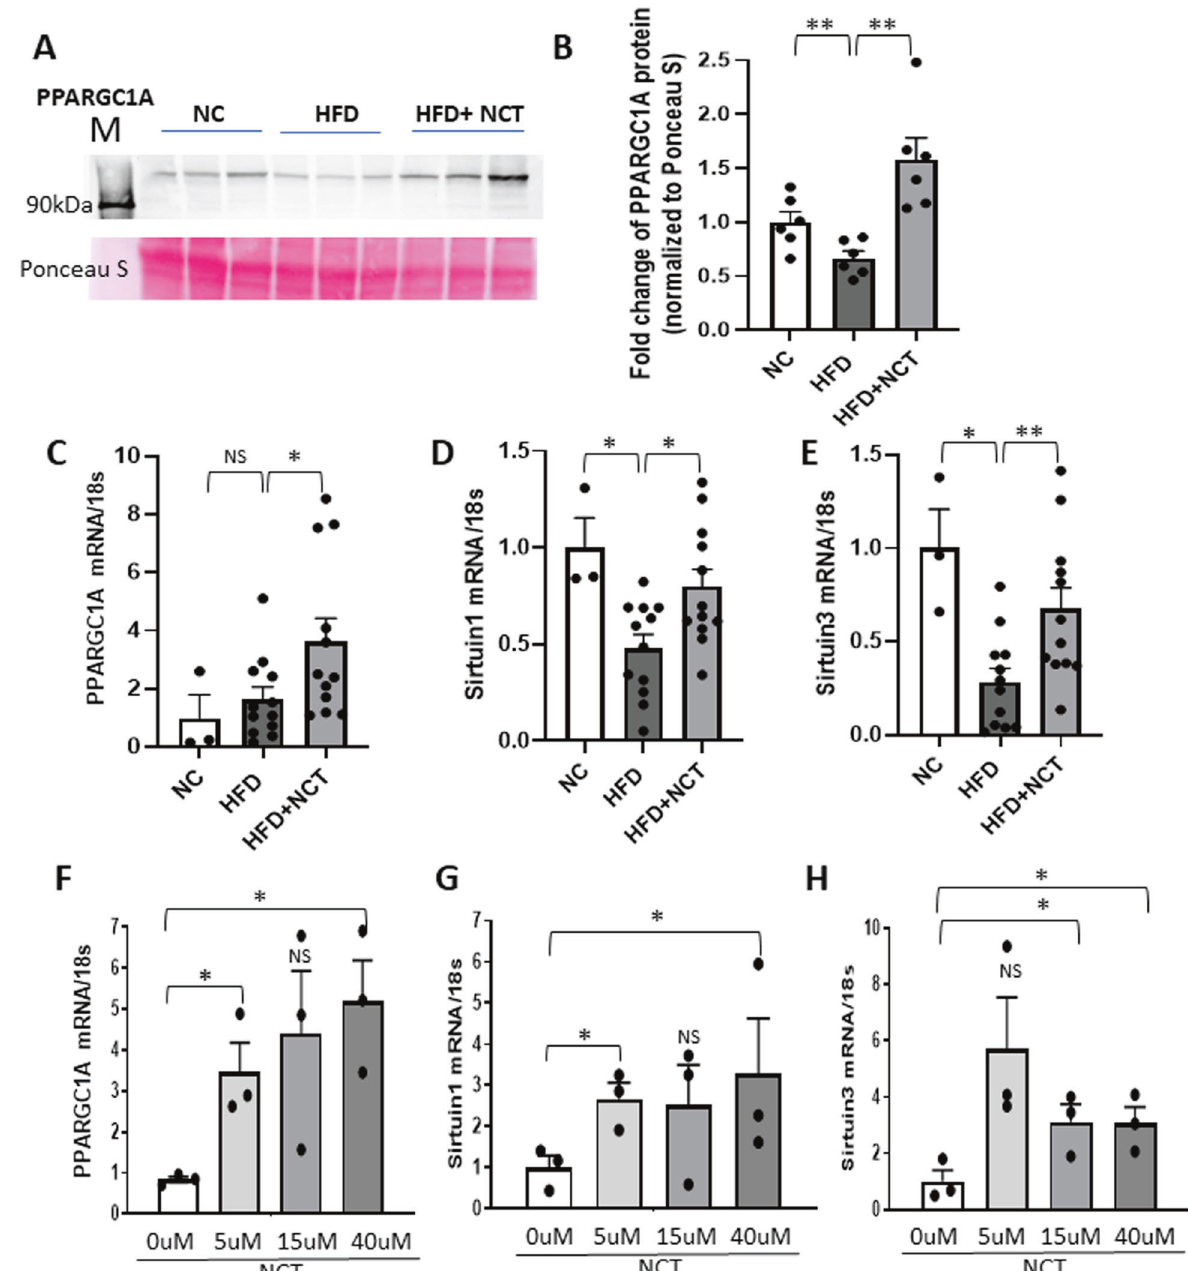
Fig. 4 NCT increased PPARGC1A signaling in mouse livers and human primary hepatocytes. A Representative pictures of western blot analysis for PPARGC1A expression and Ponceau S in mouse liver. B PPARGC1A protein expression (fold change vs. NC) in mouse liver was normalized with Ponceau S ( N = 6). C – E qPCR analysis in mouse liver of PPARGC1A , Sirtuin1 , Sirtuin3 mRNA level normalized with 18s rRNA (NC, N = 3, HFD and HFD + NCT, N = 12). F – H qPCR analysis of PPARGC1A , Sirtuin1 , and Sirtuin3 mRNA level normalized with 18s rRNA in human primary hepatocytes ( N = 3). Dots indicate individual mouse or human donors. Values represent the mean ± SEM. * p < 0.05, ** p < 0.01 (HFD vs. NC or HFD + NCT, 0 μ M vs. each concentration of NCT in human hepatocyte). NS non-signi fi